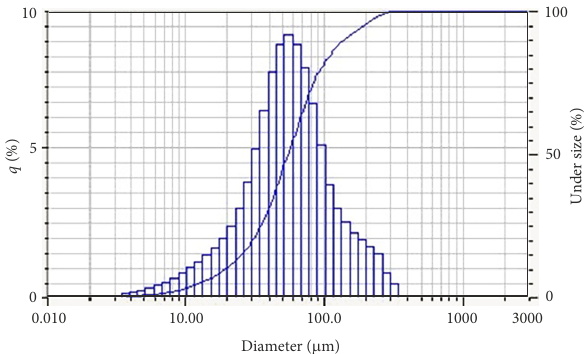
state)Figure 1. Distribution of particles of pretreated technical sulfur in water